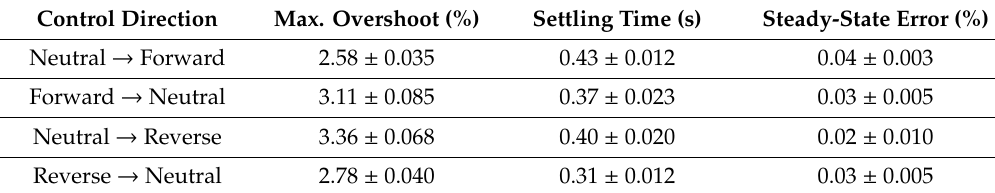
Figure 13. Position control of shuttle shifting actuator with determined PID coe ffi cients. Table 5. Results of response performance analysis for the shuttle shifting